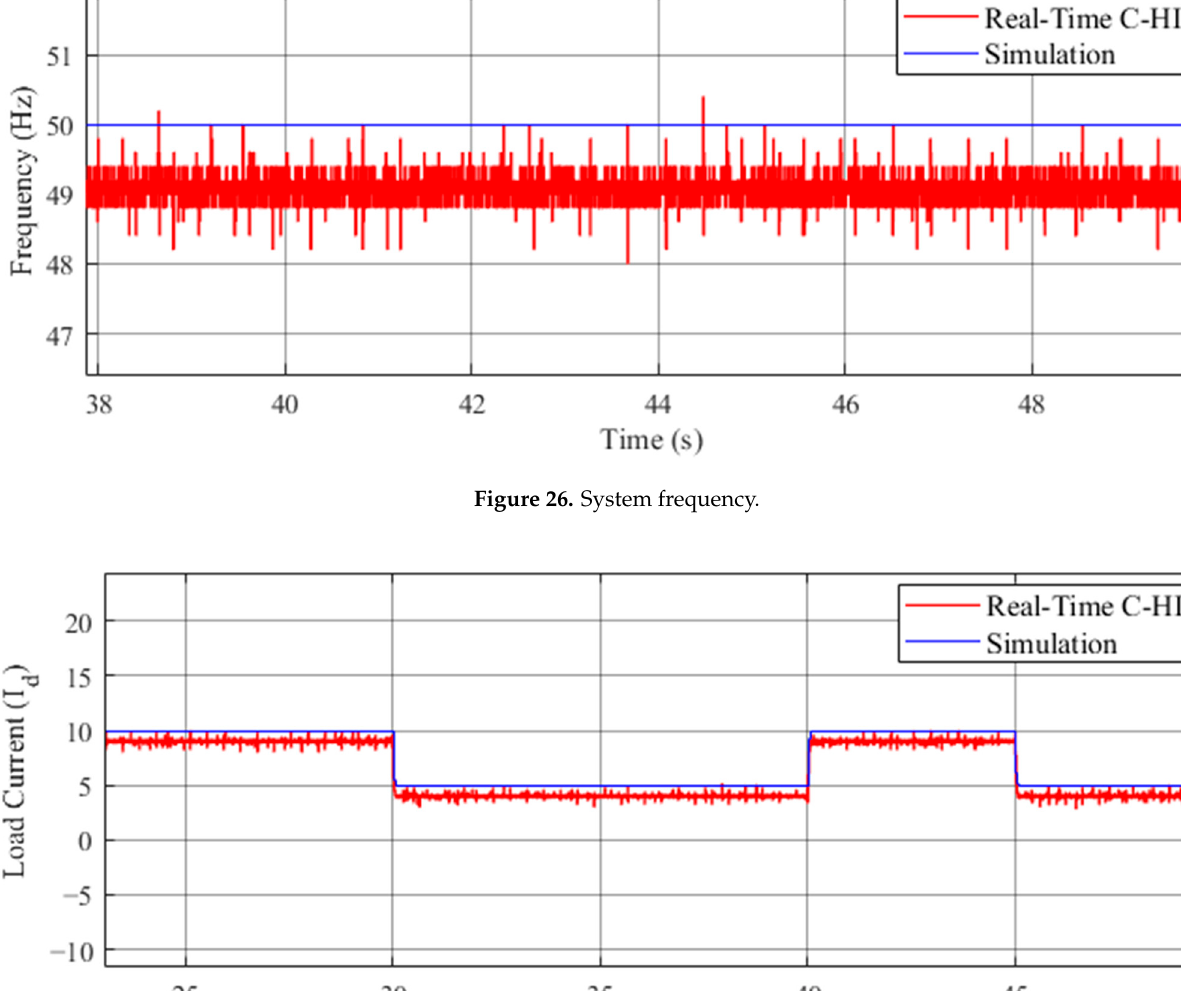
Figure 25. System output voltage.